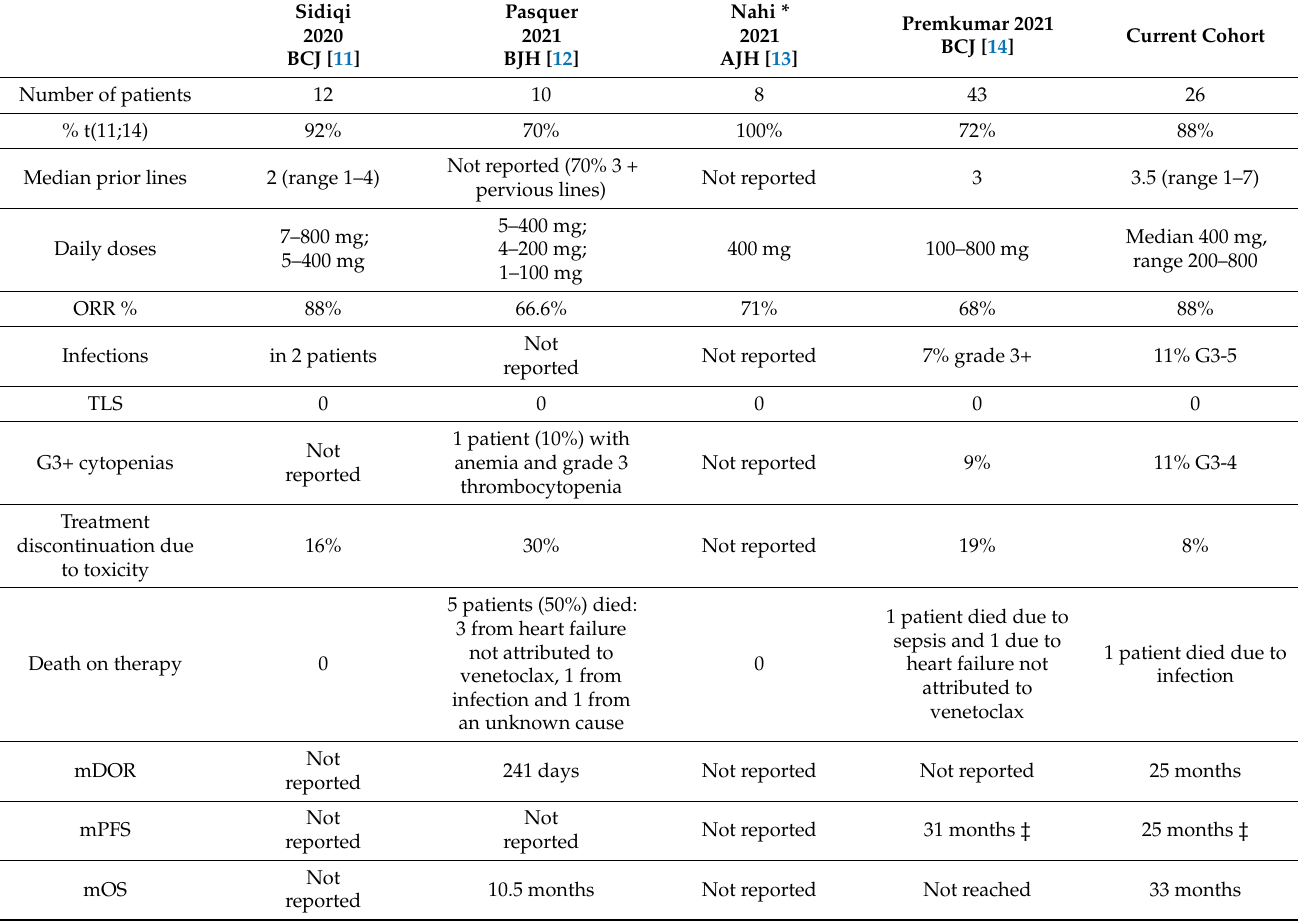
Table 4. Studies reporting on venetoclax in AL